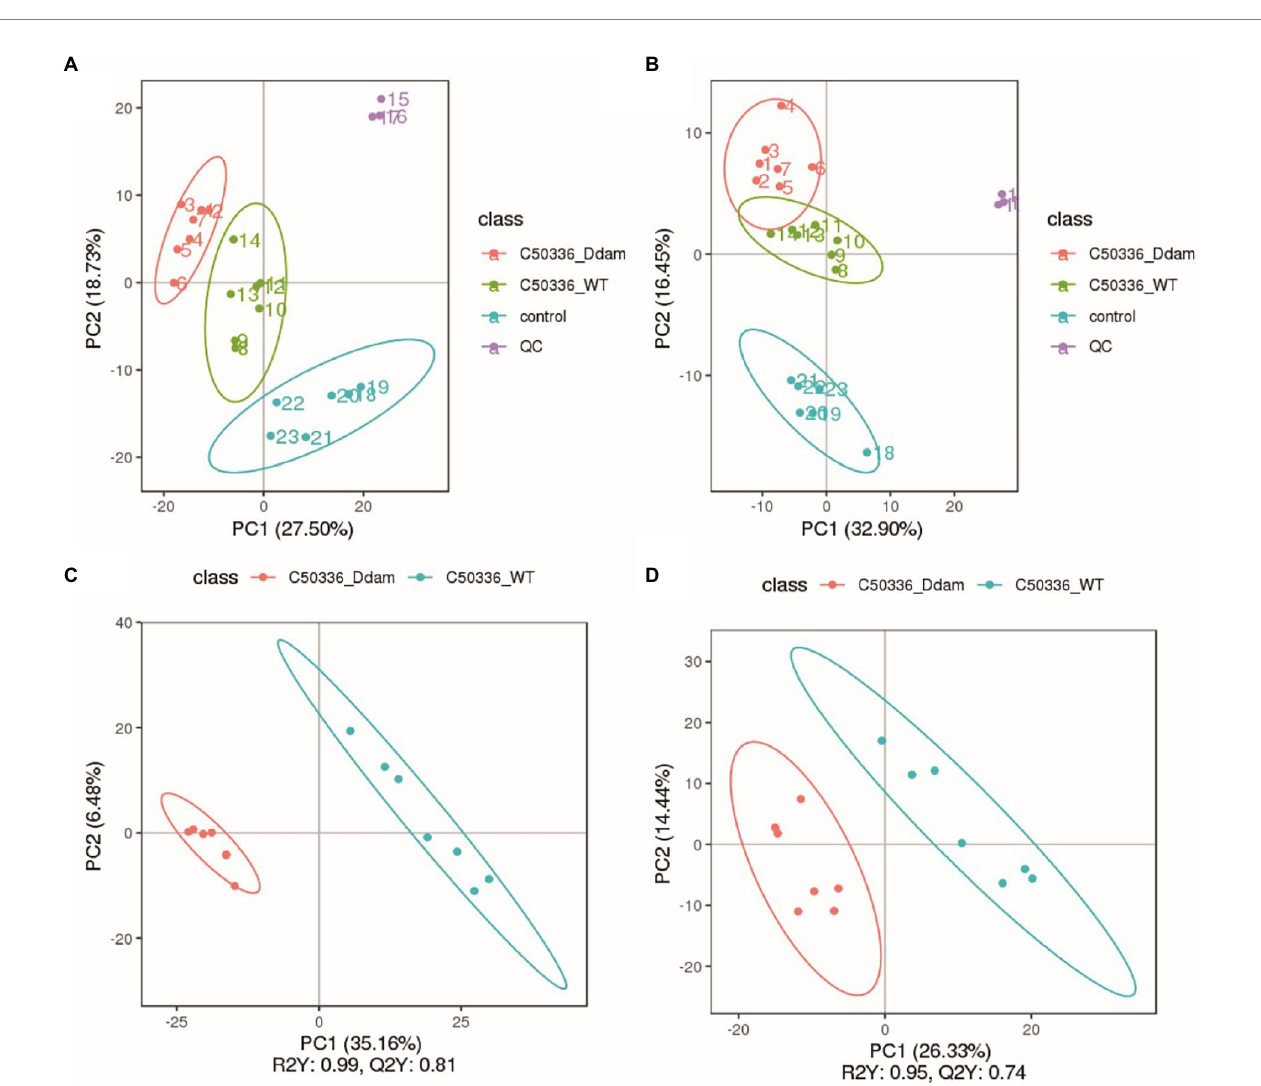
FIGURE 2 The SE dam gene regulates the intracellular metabolism of J774A.1 macrophage. (A) Non-targeted metabolomic positive ion mode PCA analysis. (B) Non- targeted metabolomic negative ion mode PCA analysis; the abscissa PC1 and ordinate PC2 in the Figure represent the scores of the first and second principal components, respectively, and the ellipse is the 95% confidence interval. (C) Non-targeted metabolomic positive ion mode PLS-DA analysis. (D) Non-targeted metabolomic negative ion mode PLS-DA analysis; the abscissa is the score of the sample on the first principal component; the ordinate is the score of the sample on the second principal component; R2Y represents the interpretation rate of the model; Q2Y is used to evaluate the predictive ability of the PLS-DA model; R2Y is ≥ Q2Y indicates that the model is well